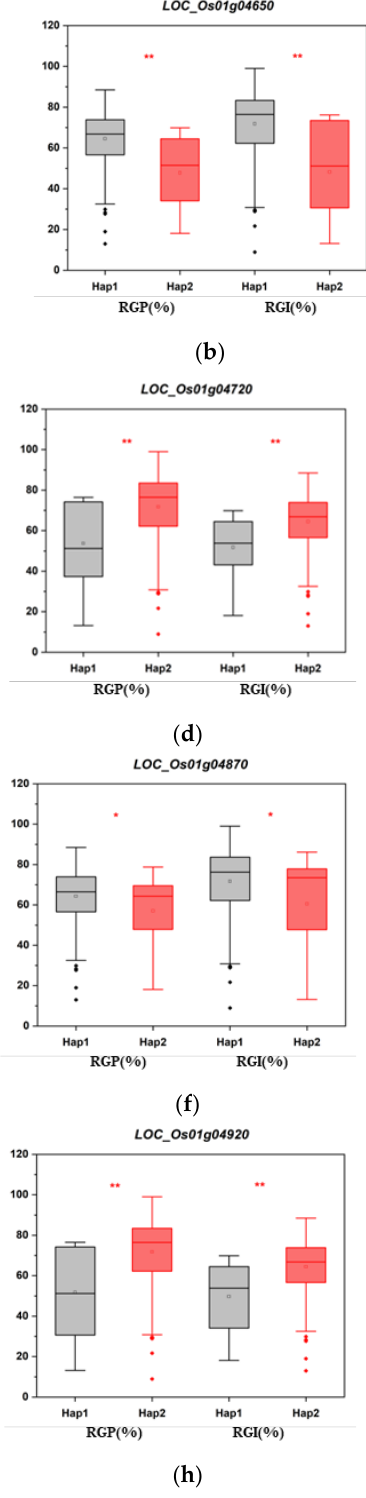
Figure 4. Candidate gene of qRG1.2 on chromosome 1. ( a ) Local Manhattan plot ( top ) and LD heatmap ( bottom ) surrounding the lead SNP. ( b ) Based on the Rice Annotation Project (RAP) [40], the 310 kb region contained 43 genes.